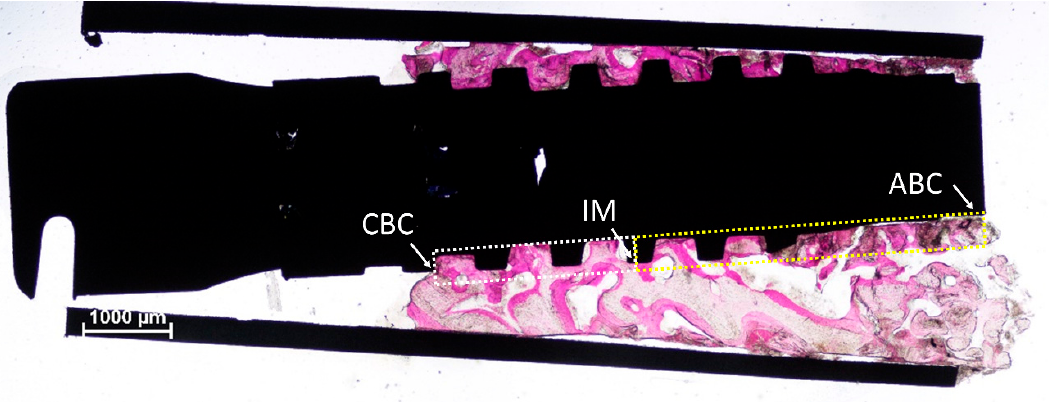
Figure 2. The trephine was used in an eccentric mode so that a smaller biopsy was obtained, but still providing enough tissue to be analyzed. The figure represents an example of histological measurements. The linear assessments were performed between the most coronal bone contact (CBC) to the implant surface to the half of the length of the implant (IM, intermediate point) and from IM and the most apical bone contact (ABC; white arrows). The morphometric measurements were also performed both in the coronal (white dotted lines) and apical (yellow dotted lines) regions. Acid fuchsine and toluidine blue stain.